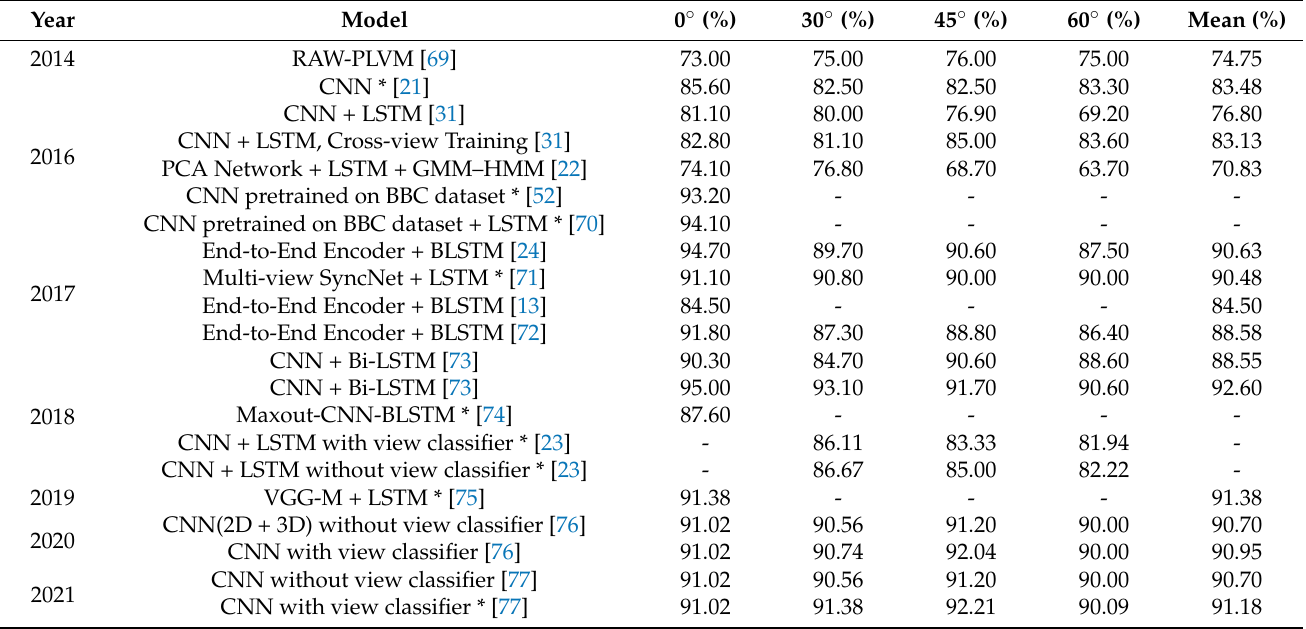
Table 3. Performance of existing models on the OuluVS2 dataset.